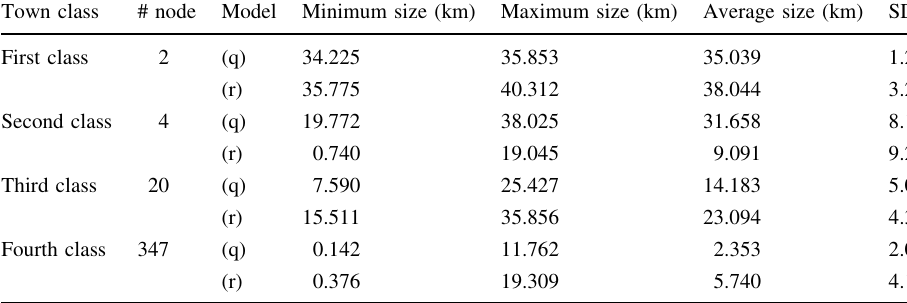
Table 3 Intercity rail transit size based on society and economy